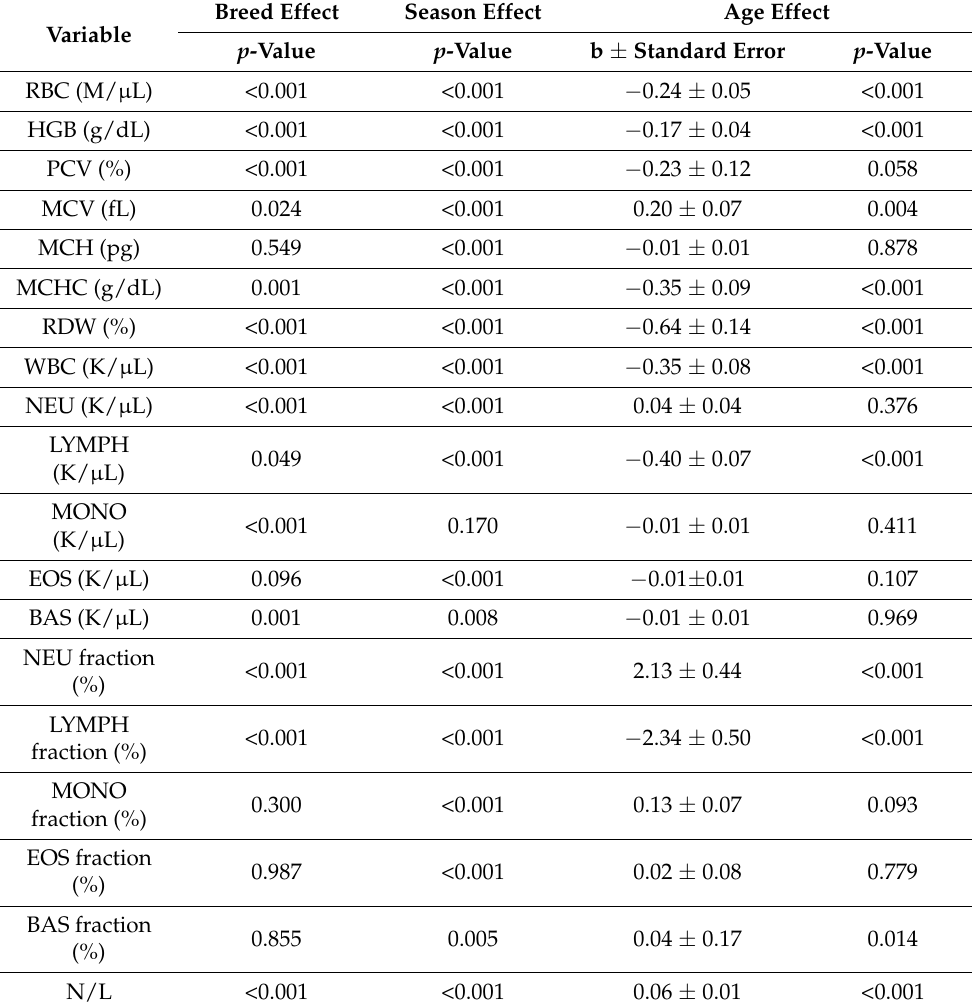
Table 3. Results of the mixed linear model that analyzed the main effects of breed, season, and age on the evaluated parameters. For the age effect (included in the models as a continuous variable), the parameter estimates (b) with its standard error are also